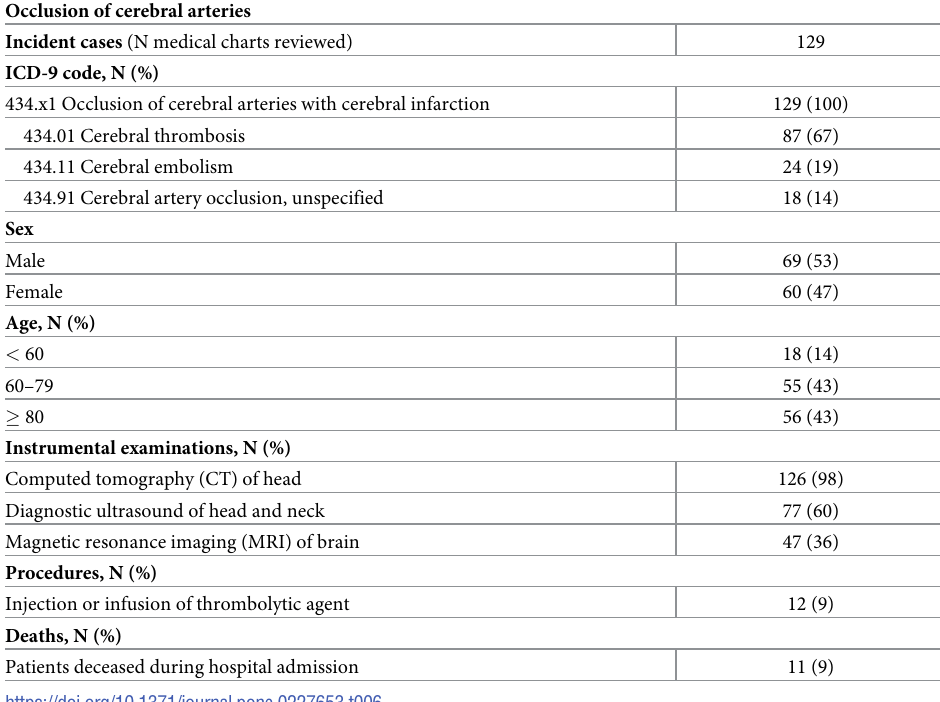
Table 6. Characteristics of patients with occlusion of cerebral arteries who were identified in the Regional Admin- istrative Database of Umbria. Occlusion of cerebral arteries Incident cases (N medical charts reviewed) 129